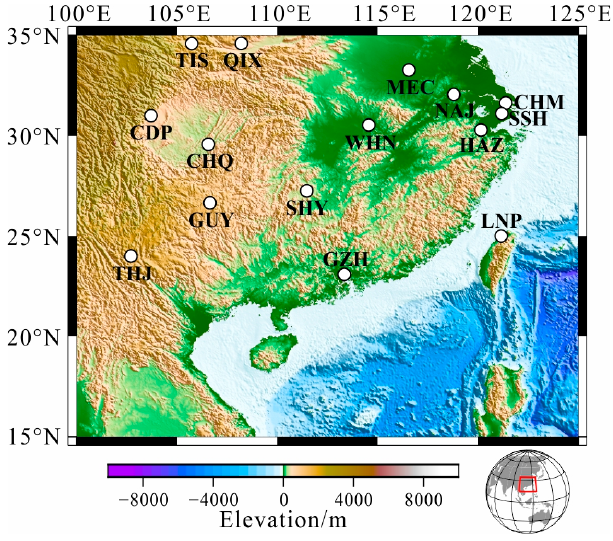
Figure 1. Locations of the selected geomagnetic observatories in South China. Table 1. Station details of the observatories used in this article. GM corresponds to the geomagnetic coordinates, and the data length is the duration of the recorded geomagnetic field data time series at the station. WDC means the data were downloaded from the World Data Center, and GNC means the data were obtained from the Geomagnetic Network of China.